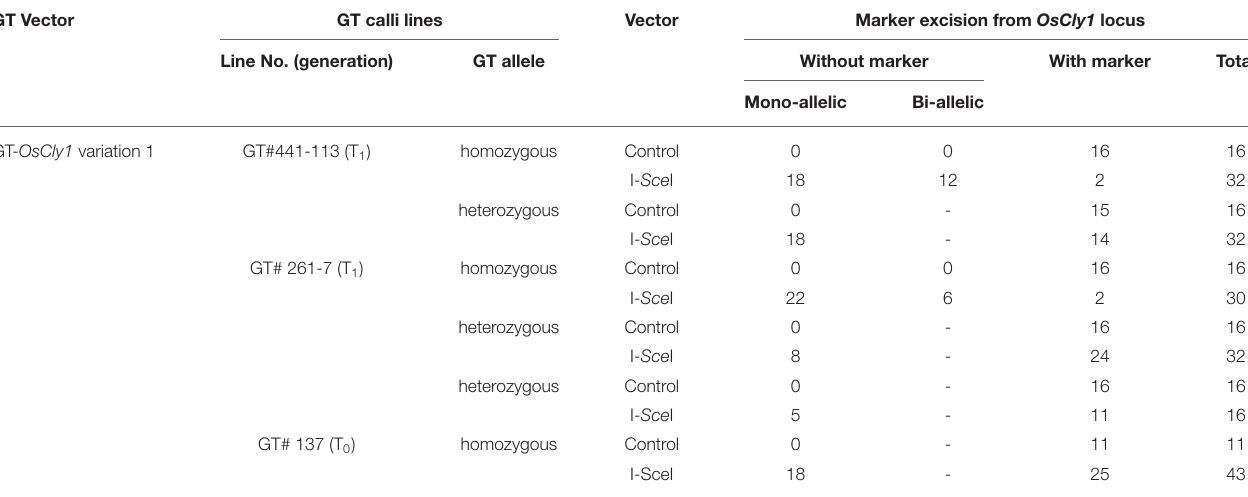
TABLE 2 | Frequency of SSA-mediated marker excision from OsCly1 locus. GT Vector GT calli lines Vector Marker excision from OsCly1 locus Line No. (generation) GT allele Without marker With marker Total Mono-allelic Bi-allelic GT- OsCly1 variation 1 GT#441-113 (T 1